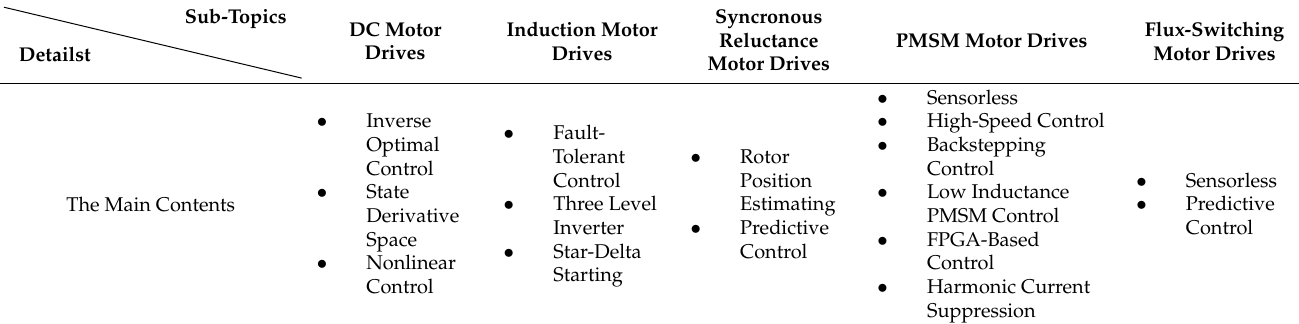
Table 1. The broad spectrum of published